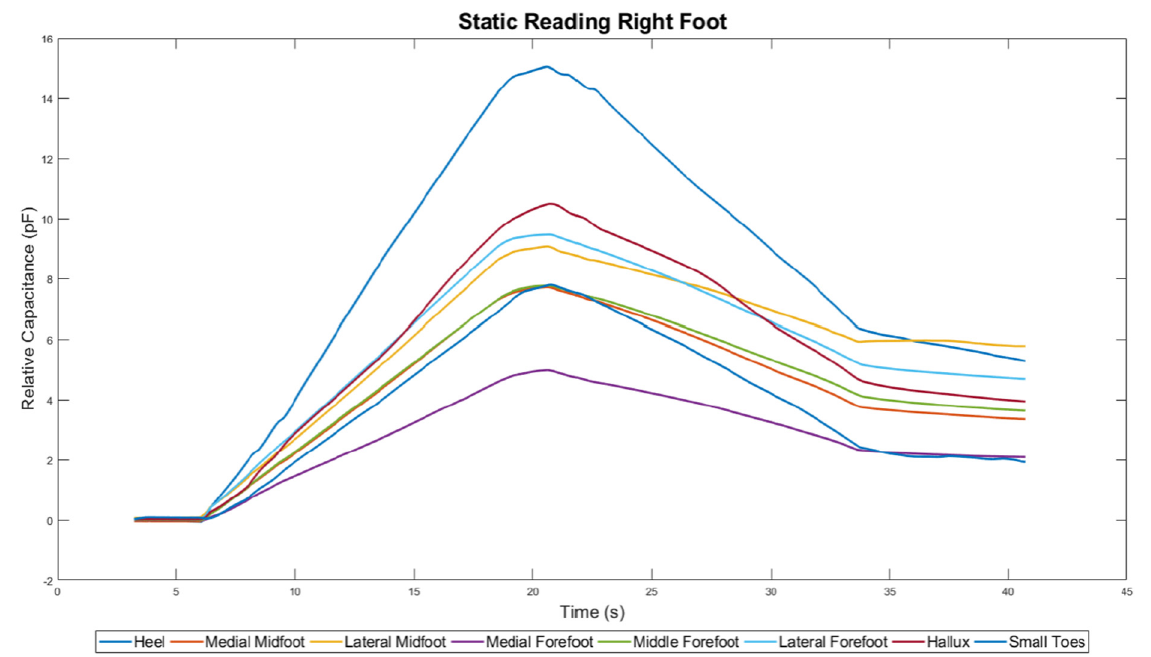
Figure 13. Line Graph of Sensor Prototype Readings from LabVIEW.